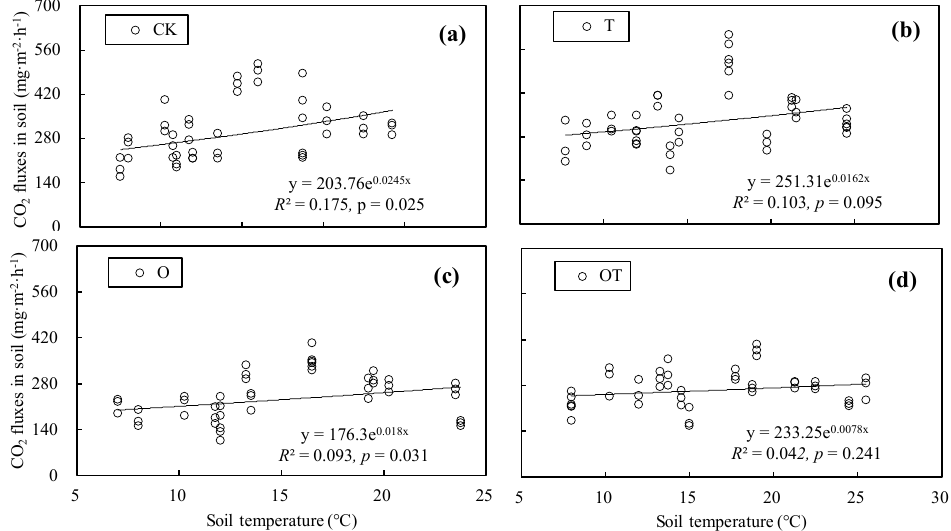
Figure 5. Relationship between soil respiration rates and soil temperature in winter-wheat farmland under different treatments. ( a ), ( b ), ( c ), and ( d ), the relationship between soil respiration rates and soil temperature in winter-wheat farmland under the CK, T, O, and OT treatments, respectively.